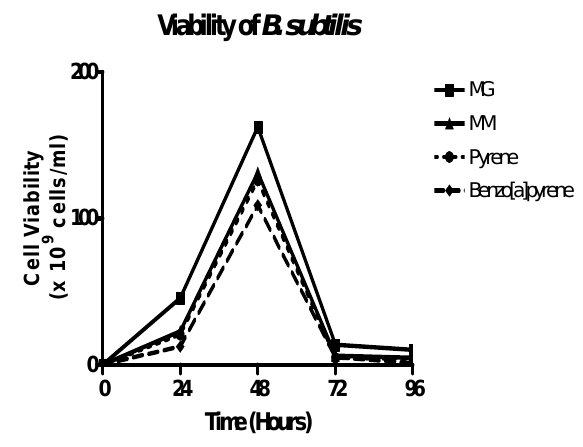
Figure 2: Viability of B. subtilis in MM, MG and